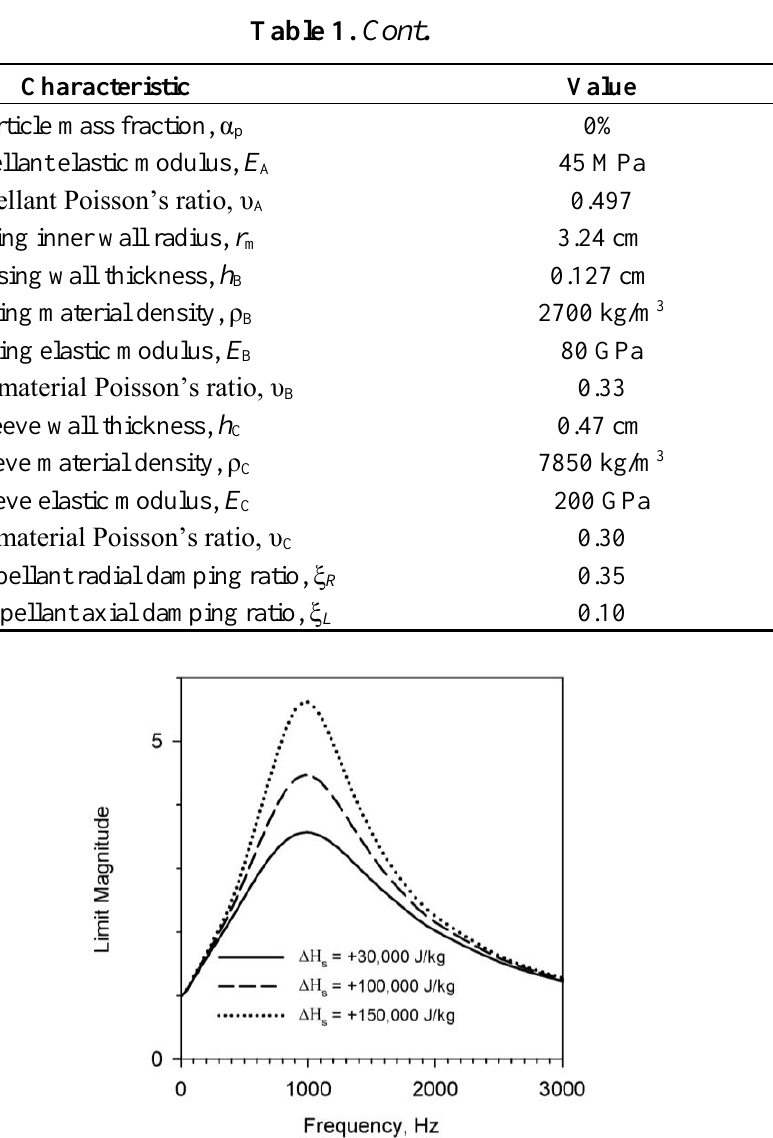
= 20,000 s −1 ; differing values b